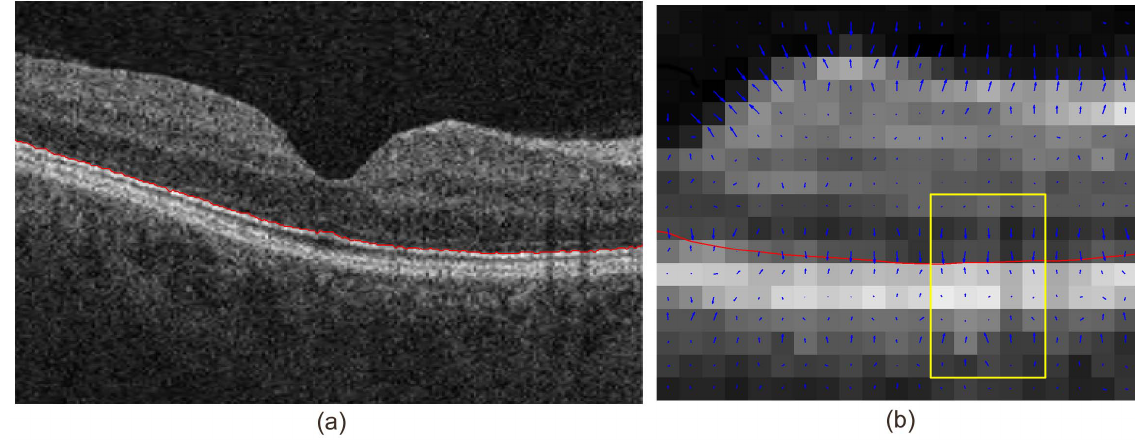
Figure 3. 2D deformation field of one B-scan in a OCT volume. (a) A single boundary was delineated in one B-scan of a OCT volume; (b) The 2D deformation field of the re-sampled B-scan indicates the actual boundary location within each voxel under partial volume effects.